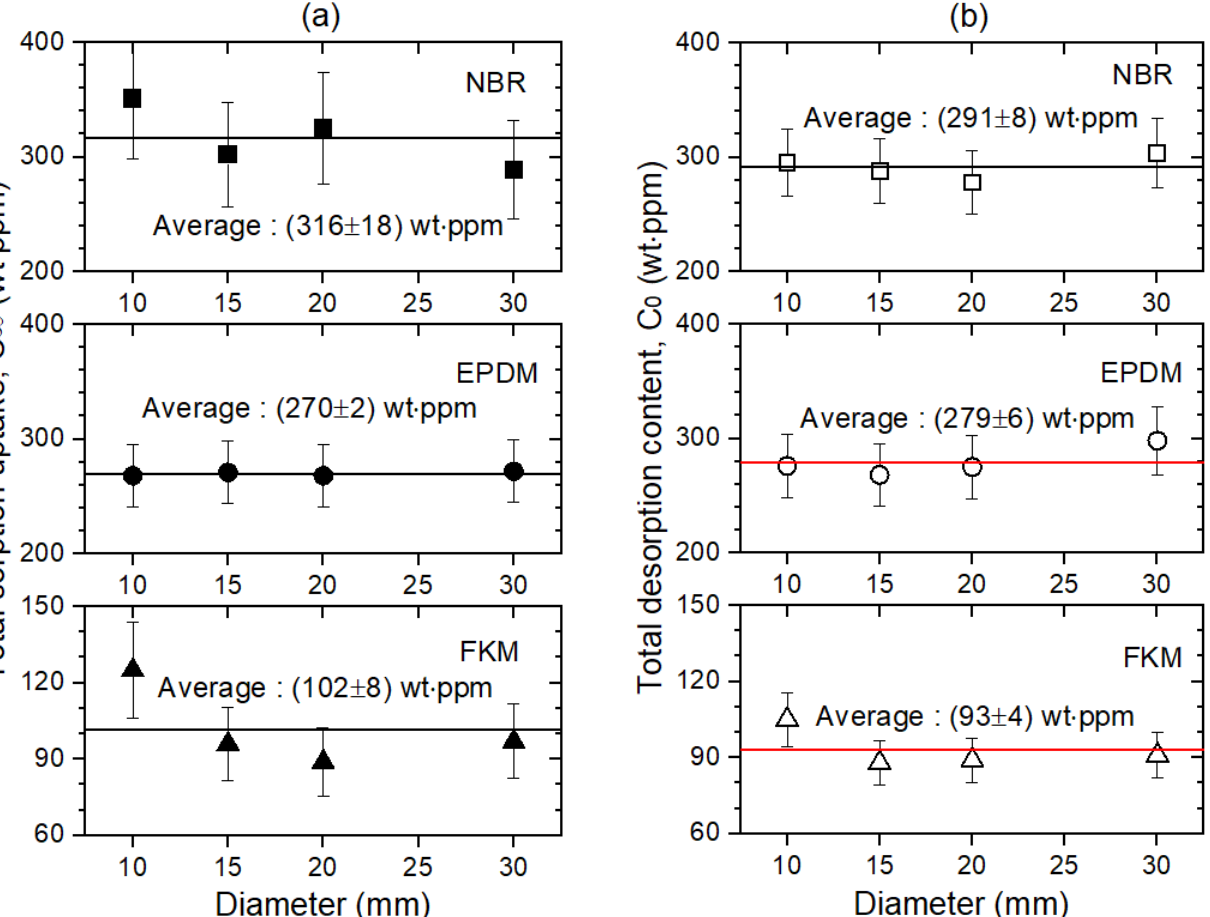
Figure 4. ( a ) Total H 2 sorption content, C ∞ , and ( b ) total H 2 desorption content, C 0 , as a function of the specimen diameter in spherically-shaped NBR, EPDM, and FKM. The horizontal line indicates the average value.